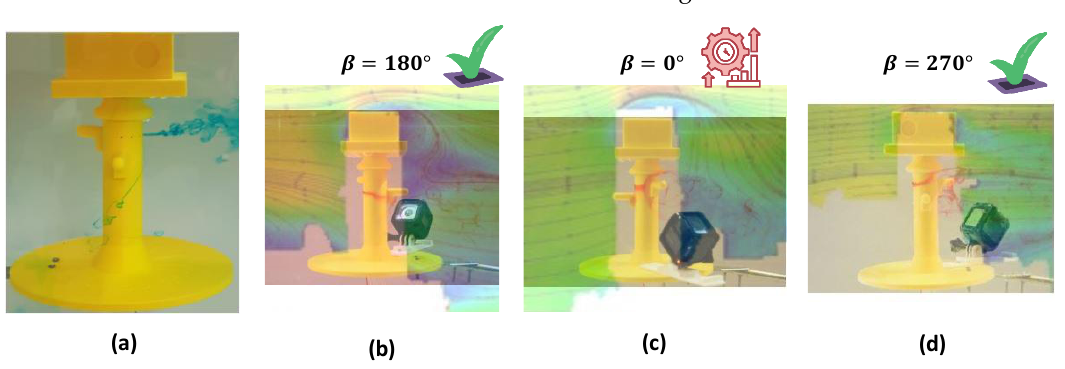
Figure 10. Previous tests with the Mars Rover “ Curiosity ” ( a ) Mast and booms prototype tested; ( b ) Comparison results at β = 180° ; ( c ) Comparison results at β = 0° ; ( d ) Comparison results at β = 270° .